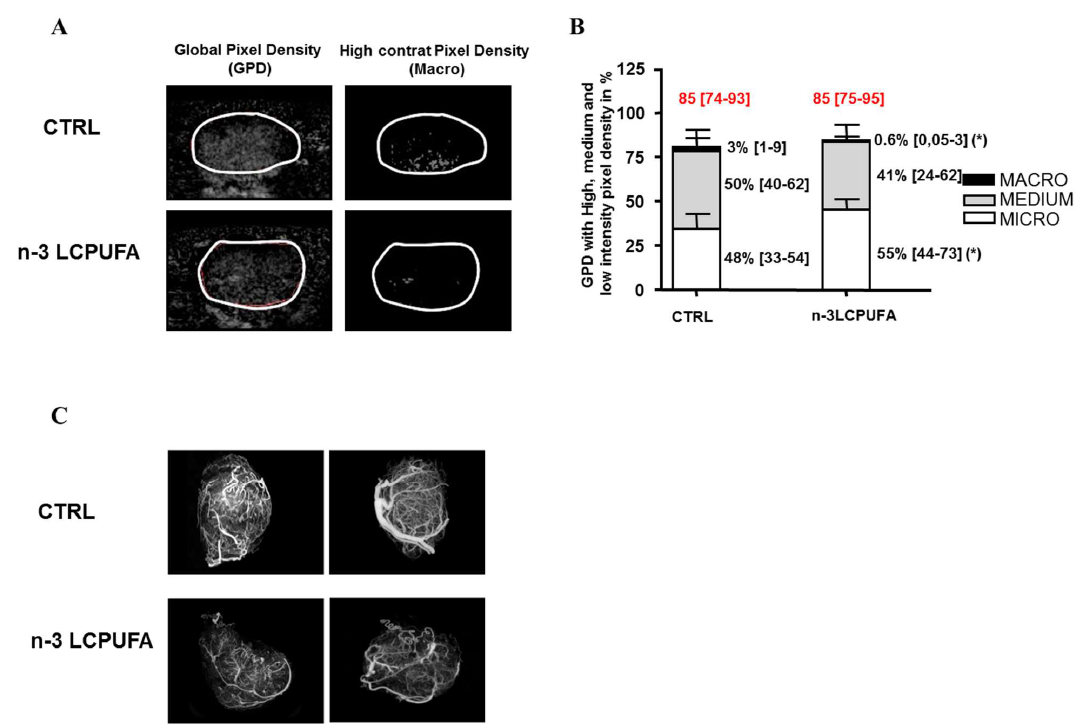
Figure 1. An n-3 long chain Polyunsaturated Fatty Acid (n-3 LCPUFA)-enriched diet induces a remodeling of the tumor vasculature in favor of the microvasculature. Female rats carrying mammary tumors were fed a control diet or an n-3 LCPUFA-enriched diet. Tumor vascularization was quantified using contrast-enhanced ultrasound (CEUS) methodology after SonoVue ® microbubbles injection when tumors reached 2 cm² ( n = 14 by nutritional group). Using the MATLAB ® software a specific analysis of CEUS signal lead us to evaluate several vascular parameters within tumors defined as the region of interest (ROI). The global contrasted-pixel density (GPD) took into account all pixels with contrast signal and reflected a global vascular density. With discrimination of pixels according to their contrast signal intensity, three vascular compartments (macro-, medium- and micro-vasculature) were quantified and expressed as a proportion (%) of the global vascular network. ( A ) Representative images obtained by CEUS showing GPD reflecting global vascular density left panels) and macrovascularization (right panels). Contours of tumors were surrounded by the white line (ROI). Magnification factor: 1.5×. ( B ) Histograms representing the GPD, global vascular density (with its quantification in red), subdivided in the three compartments (micro, medium and macrovasculature) (bar and values on the right: median and interquartile range, 25–75th percentile) and obtained in mammary tumors of rat fed a control or n-3 LCPUFA diet ( n = 14 per nutritional group). ( C ) Three-dimensional images of tumor vasculature after cast realized with two control and two n-3 LCPUFA tumors. * p < 0.05 (compared to control group, Mann–Whitney test). Magnification factor: 1.5×.